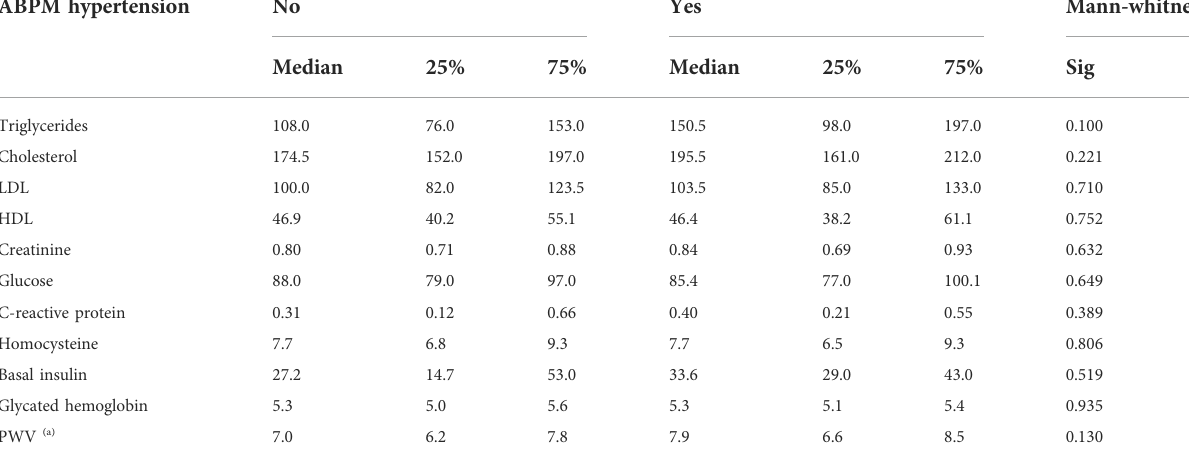
TABLE 7 Evaluation of the presence of hypertension (ABPM) according to serum levels of cardiovascular disease markers. ABPM